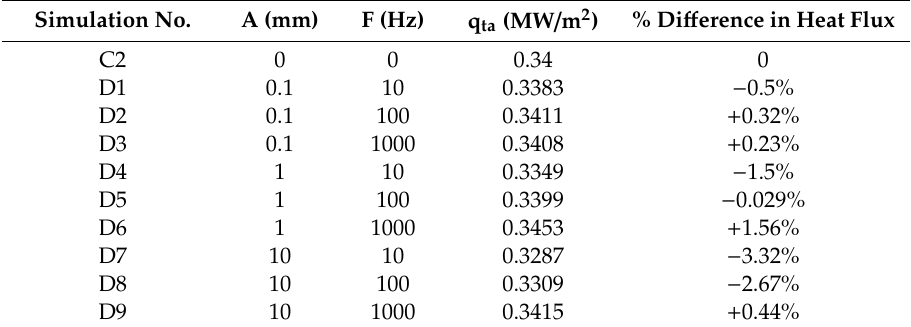
Figure 16. Droplet oscillation for a surface vibration amplitude of 10 mm at frequencies of 10 Hz, 100 Hz, and 1000 Hz. Table 4. Time-averaged heat flux corresponding to stationary and dynamic